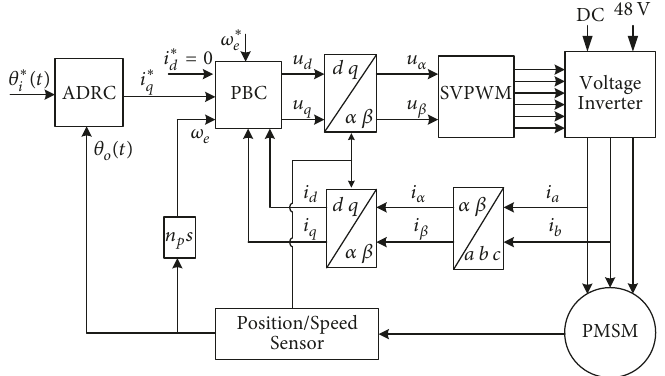
Figure 3: Diagram of the ADRC-PBC